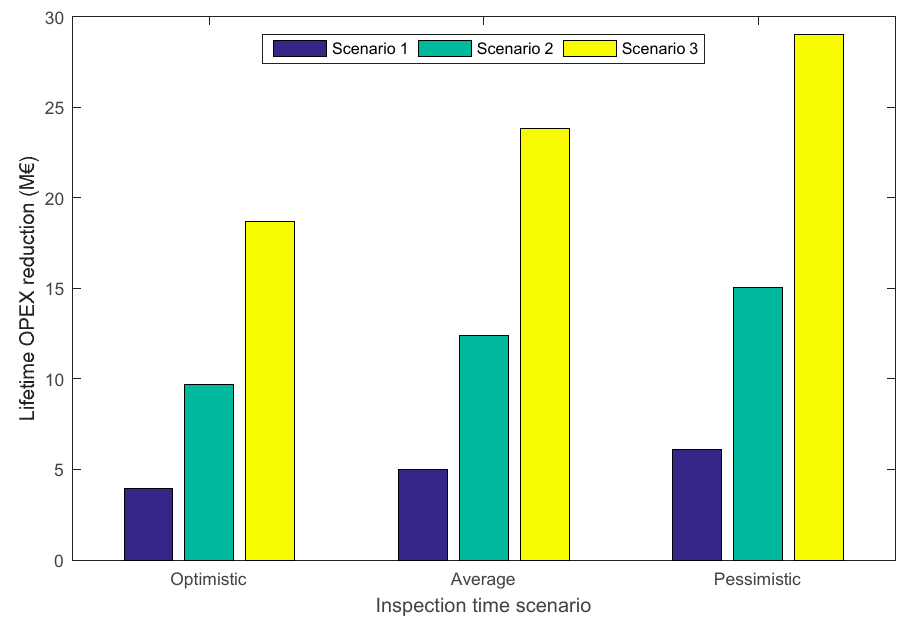
Figure 6. Lifetime OPEX reduction from baseline case.